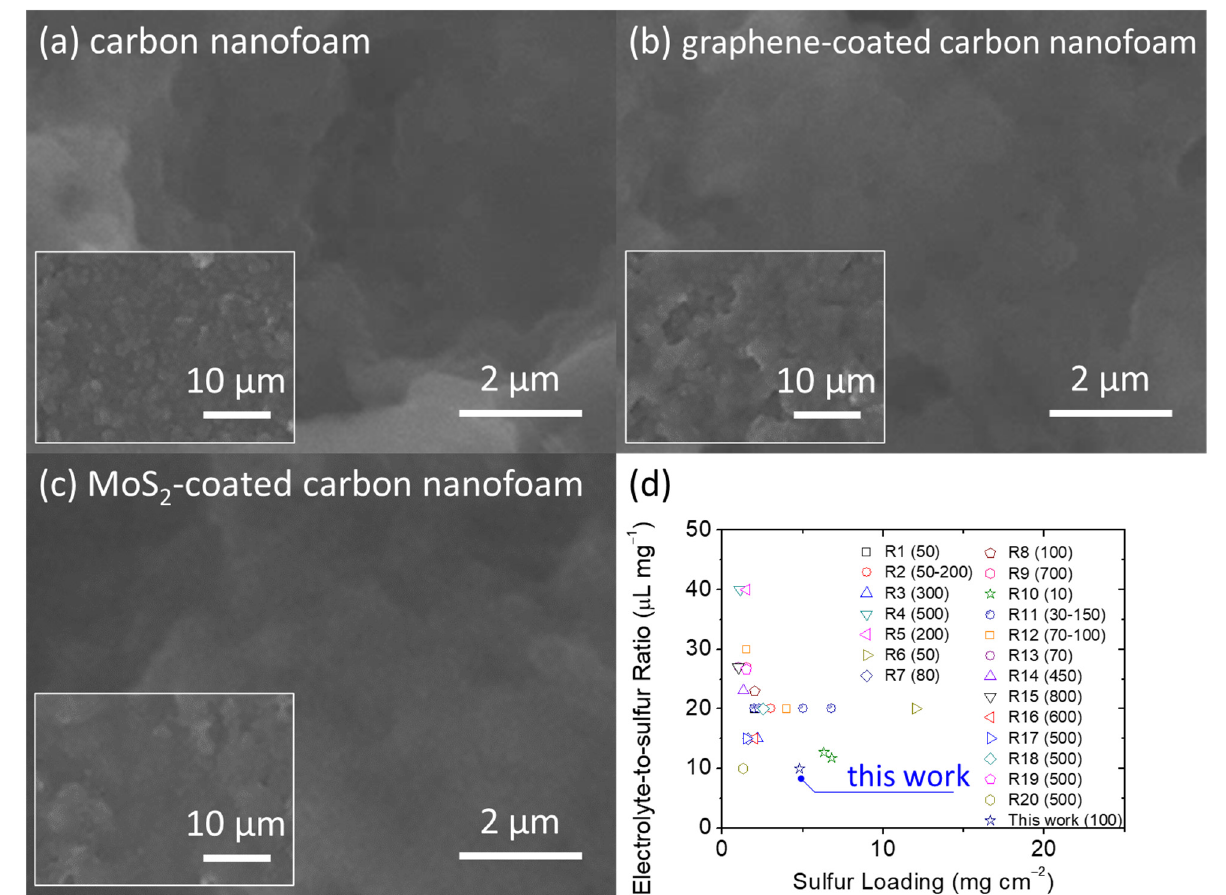
Figure 5. Battery performance: microstructural inspection of ( a ) carbon nanofoam, ( b ) graphene-coated carbon nanofoam, and ( c ) MoS 2 -coated carbon nanofoam retrieved from cycled cathodes after 100 cycles. ( d ) Comparison with literature data: sulfur loading, electrolyte-to-sulfur ratio, and the cycle life in the parentheses.